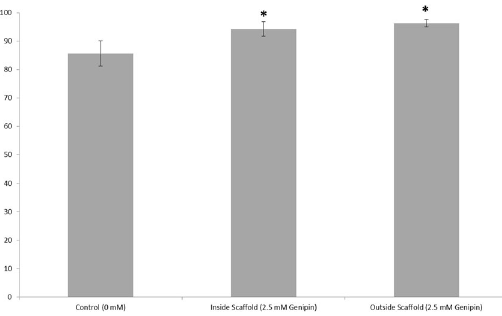
Figure 6. 3D fibrin scaffolds crosslinked with genipin do not induce death of hiPSC-derived neural aggregates. Quantification of viability for hiPSC-derived neural progenitors seeded inside of 2.5 mM genipin-crosslinked scaffolds and beneath them in dual culture systems (biological n = 3, technical n = 5, data reported is mean ± standard error of the mean) * indicates p < 0.5 compared to the control.